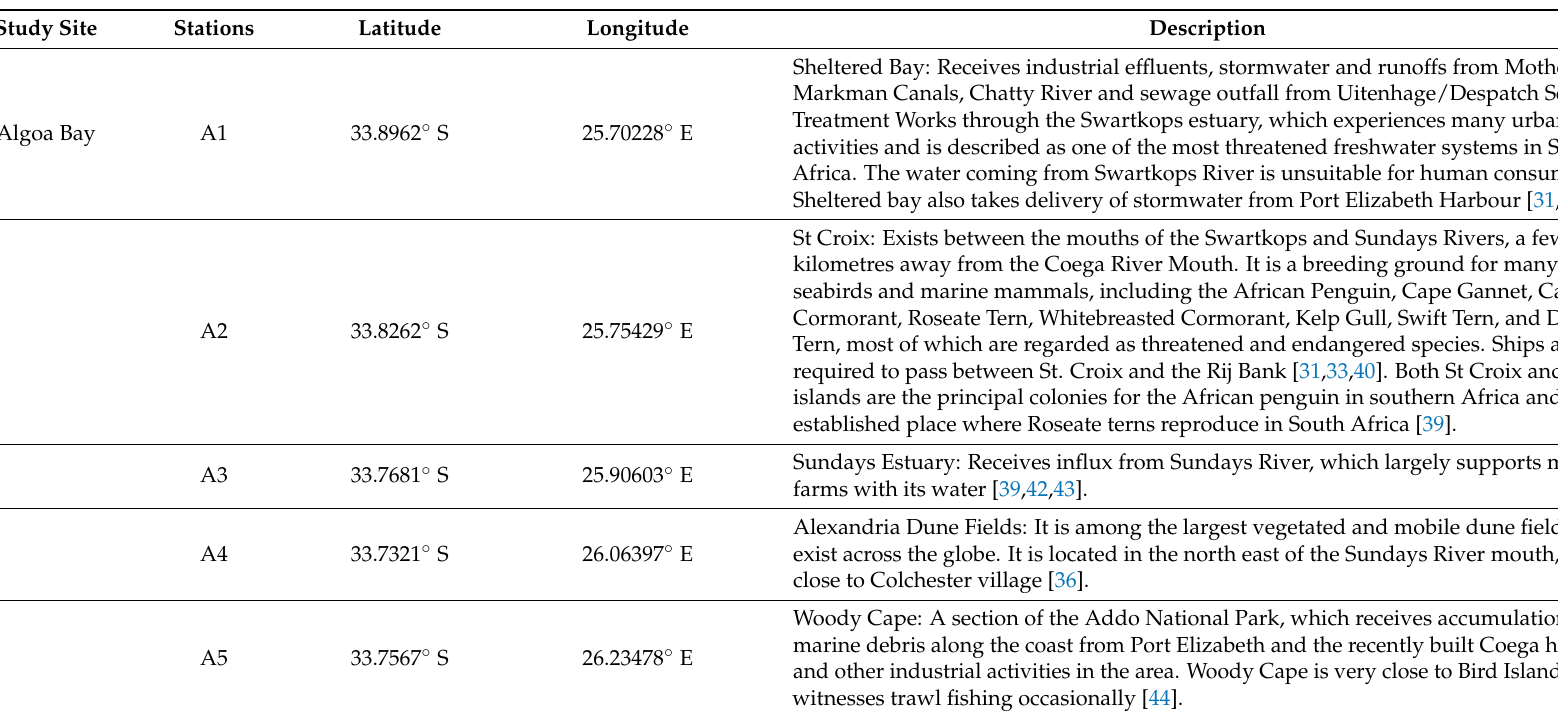
Table 1. Description of the study